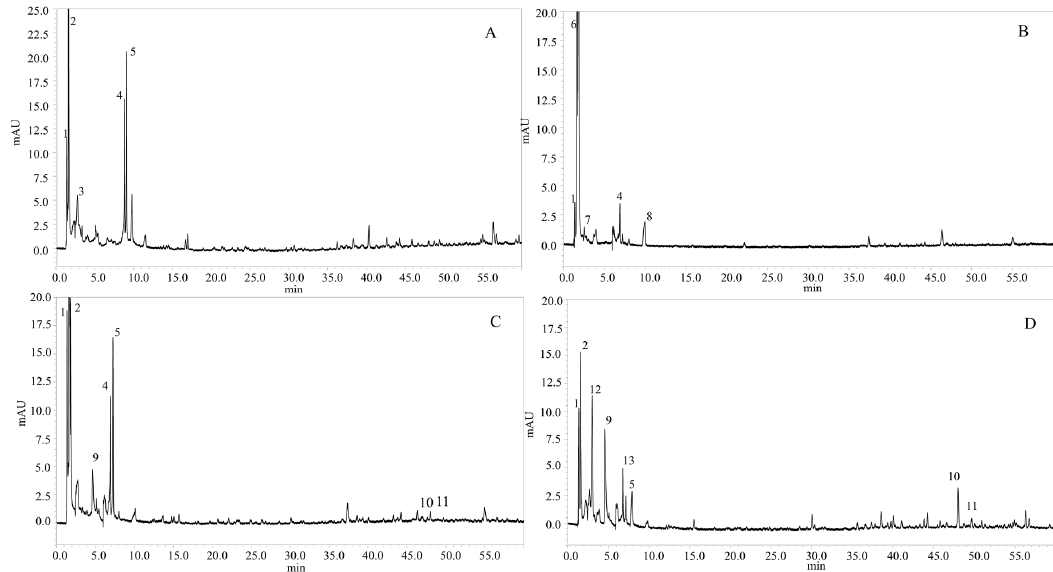
Figure 1. Chromatograms, obtained by HPLC–PDA–MS, of the polyphenolic compounds from four species of microalgae: ( A ) Phaeodactylum tricornutum , ( B ) Nannochloris sp, ( C ) Tetraselmis suecica , and ( D ) Nannochloropsis gaditana . Chromatographic conditions: See text. Peak identification is given in Table 3 ( λ =280 nm).